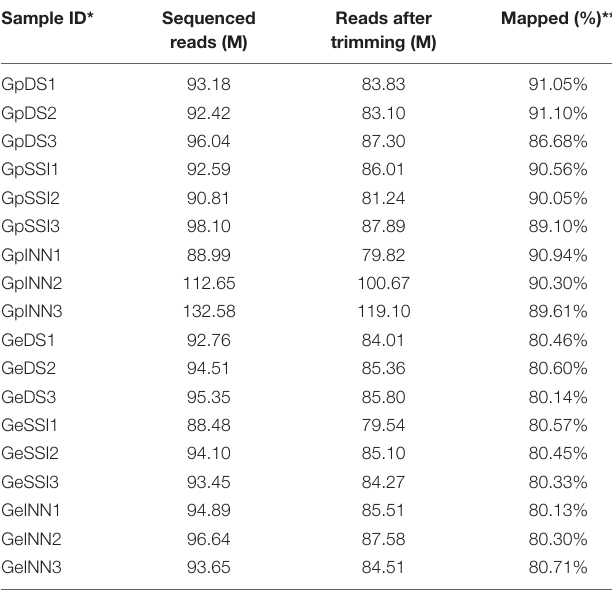
TABLE 1 | Sequencing yield, trimming, and mapping